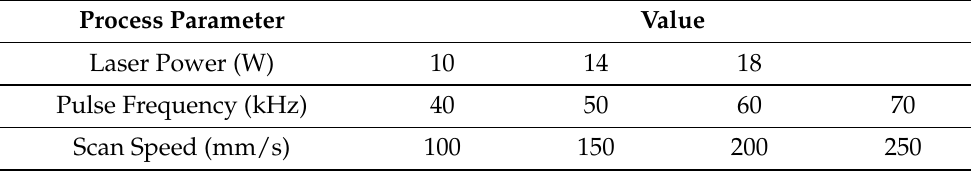
Table 4. Variation ranges of process